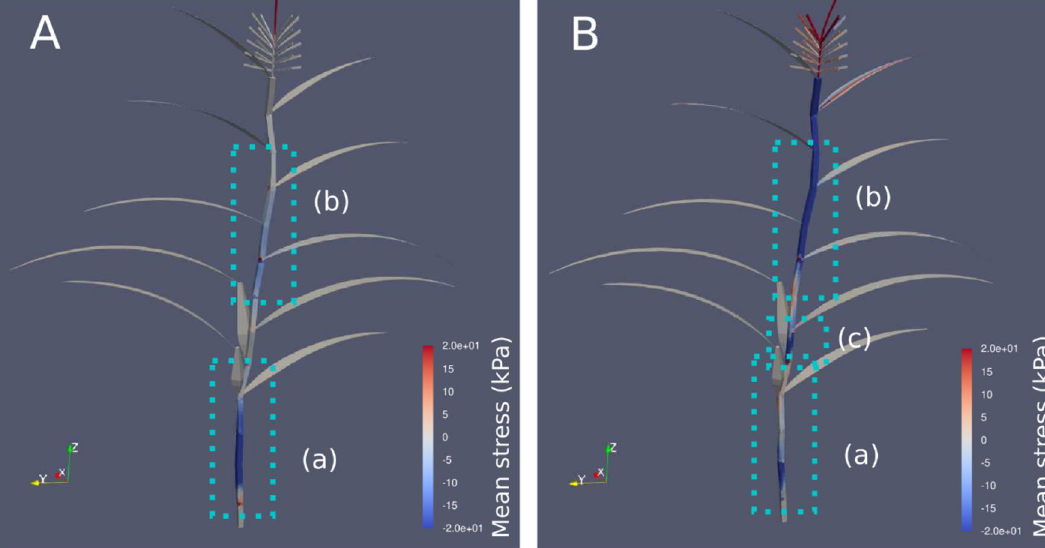
Figure 1. Preliminary finite element analysis (FEA) of a maize plant: ( A ) contour map of the mean stress at the first eigenmode, and ( B ) the second eigenmode. The results indicate that that the below-ear (inset a) and above- ear sections (inset b) deform significantly under free vibration. Thus, the Young’s modulus of these two regions may contribute essentially to the plant’s mechanical